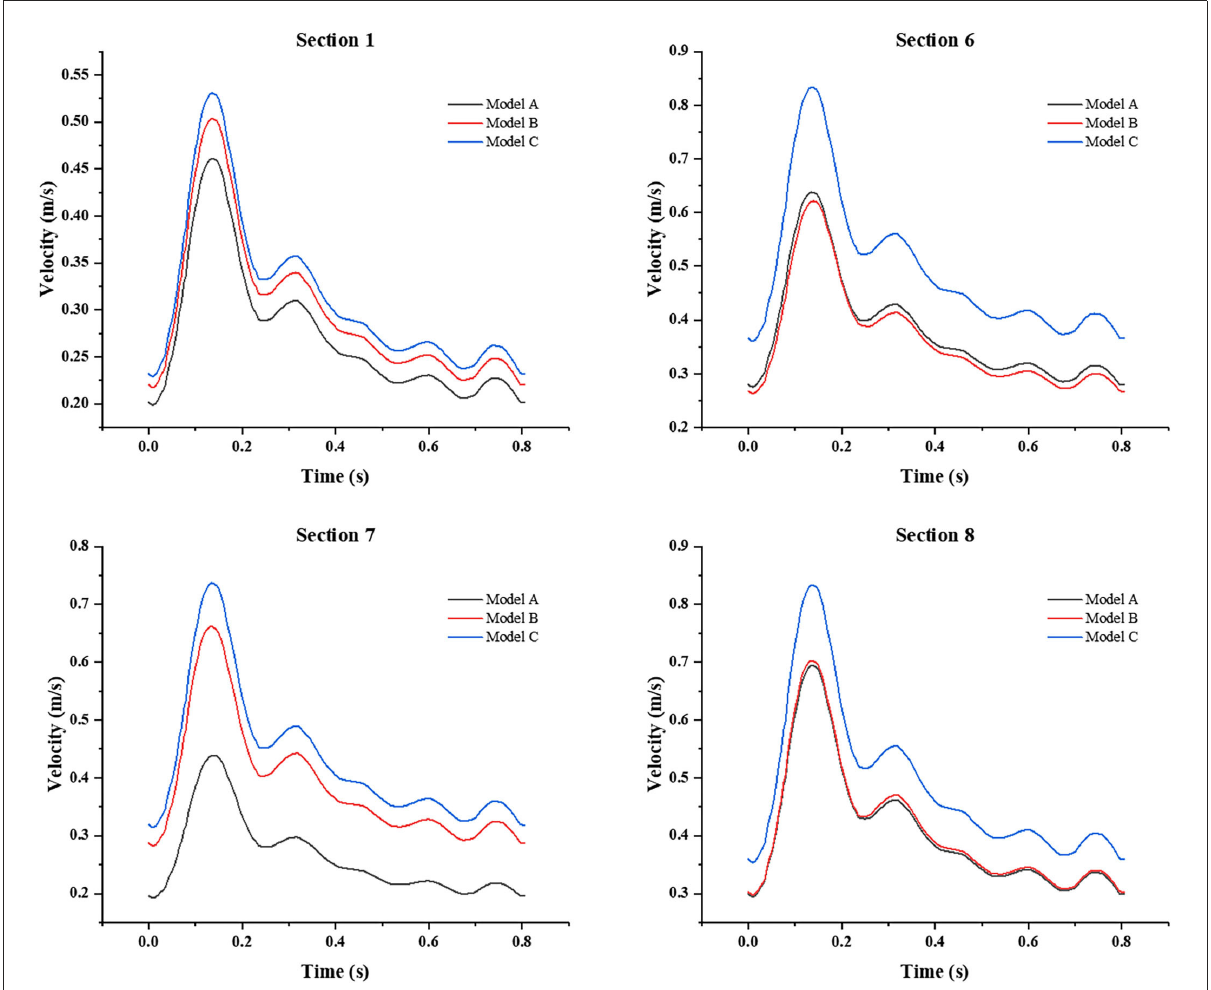
FIGURE10 The change in area-averaged velocity in cross sections over time in one cycle.